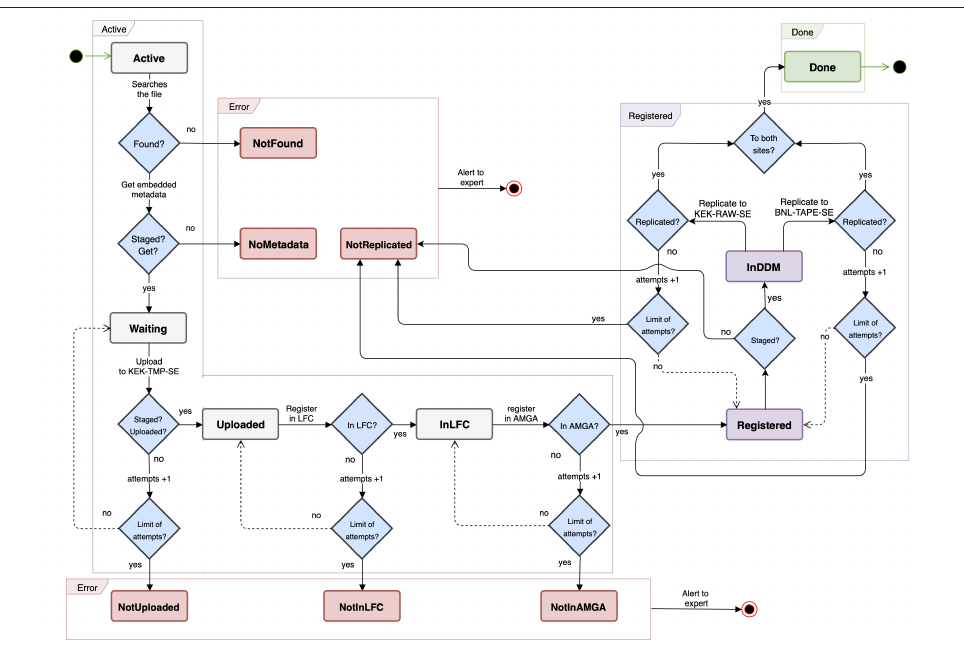
Figure 3. Status and minor status diagram for raw data files. Each step is treated by an agent, which changes the status at the end of its cycle.